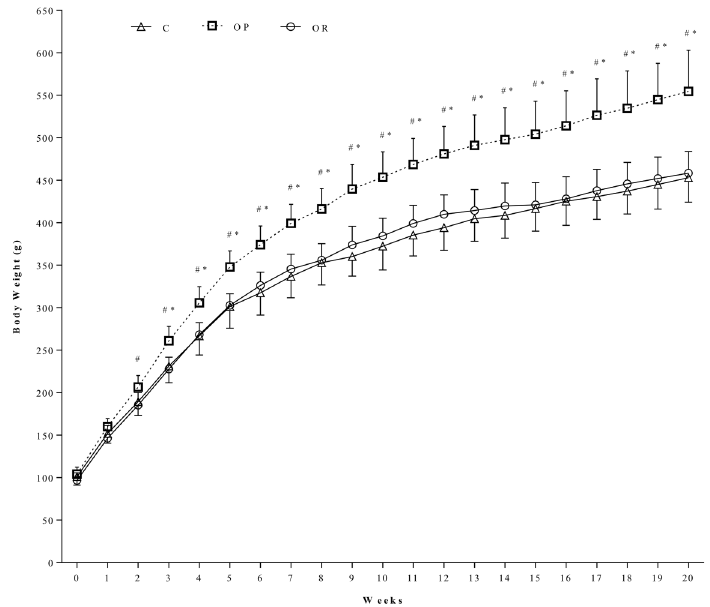
Figure 3. Evolution of body weight during the protocol of induction and exposure to obesity after 20 weeks of treatment. Control (C, n=27), obese-resistant (OR, n=19), and obese-prone (OP, n=21). Data are reported as means ± SD. *P o 0.05 OP vs C; # P o 0.05 OR vs OP (repeated measures two-way ANOVA followed by Bonferroni ’ s post hoc